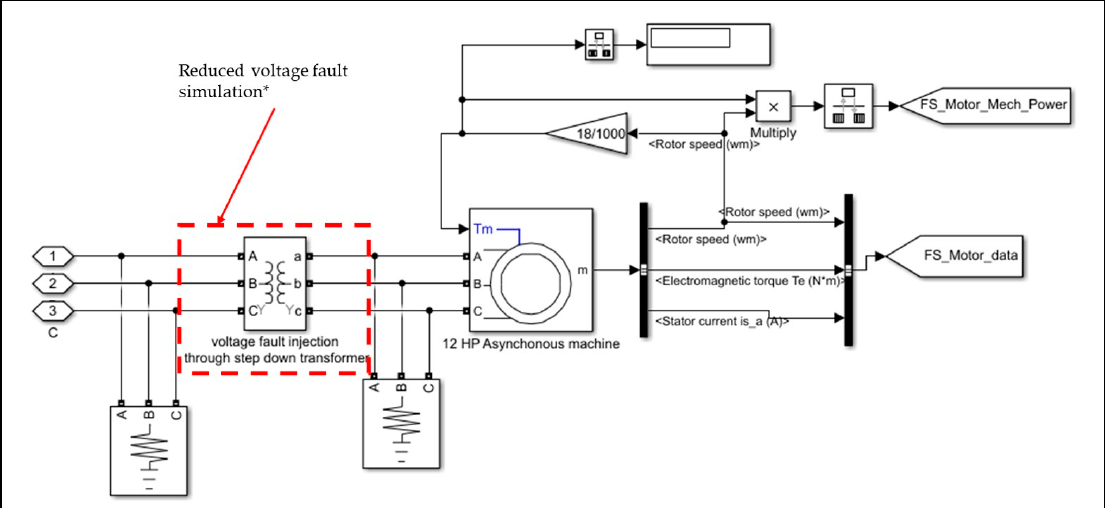
Figure 4. Fault injection in AC pump motor by reduced voltage supply